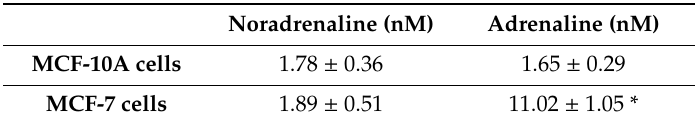
Table 1. Concentrations of noradrenaline and adrenaline in the conditioned medium of MCF-10A and MCF-7 cells, determined by HPLC-ECD.